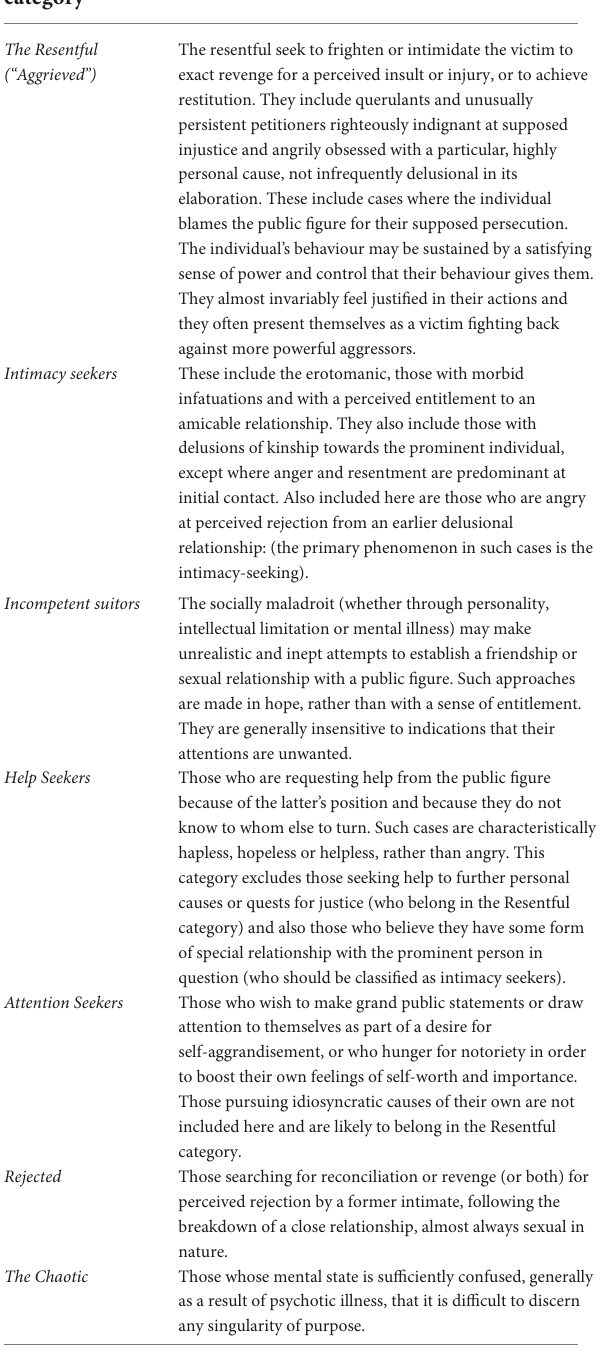
TABLE 2 Definitions of motivational categories extracted from Mullen et al. (1999) and MacKenzie et al.